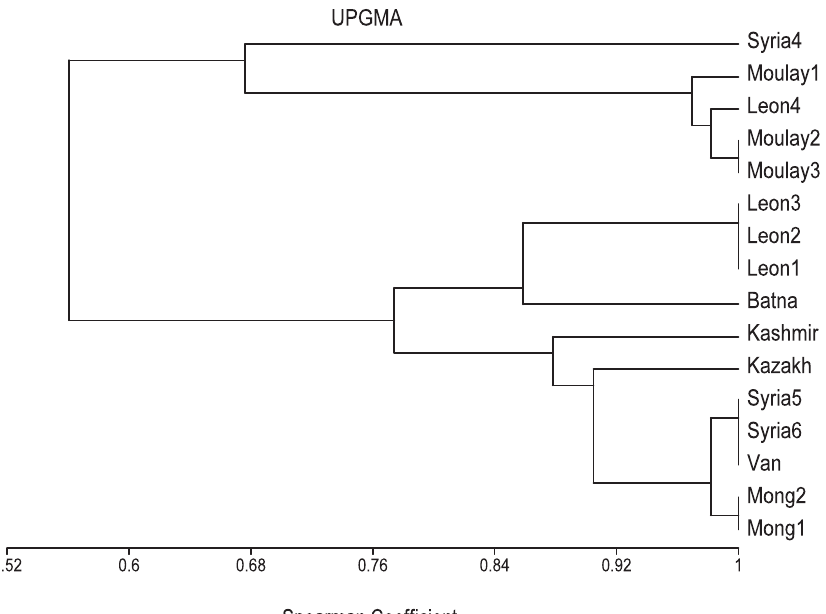
Fig. 2. – Prevalence of nematode species located in abomasum: data of 16 surveys in steppe and cluster analysis using UPGMA and Spearman correlation